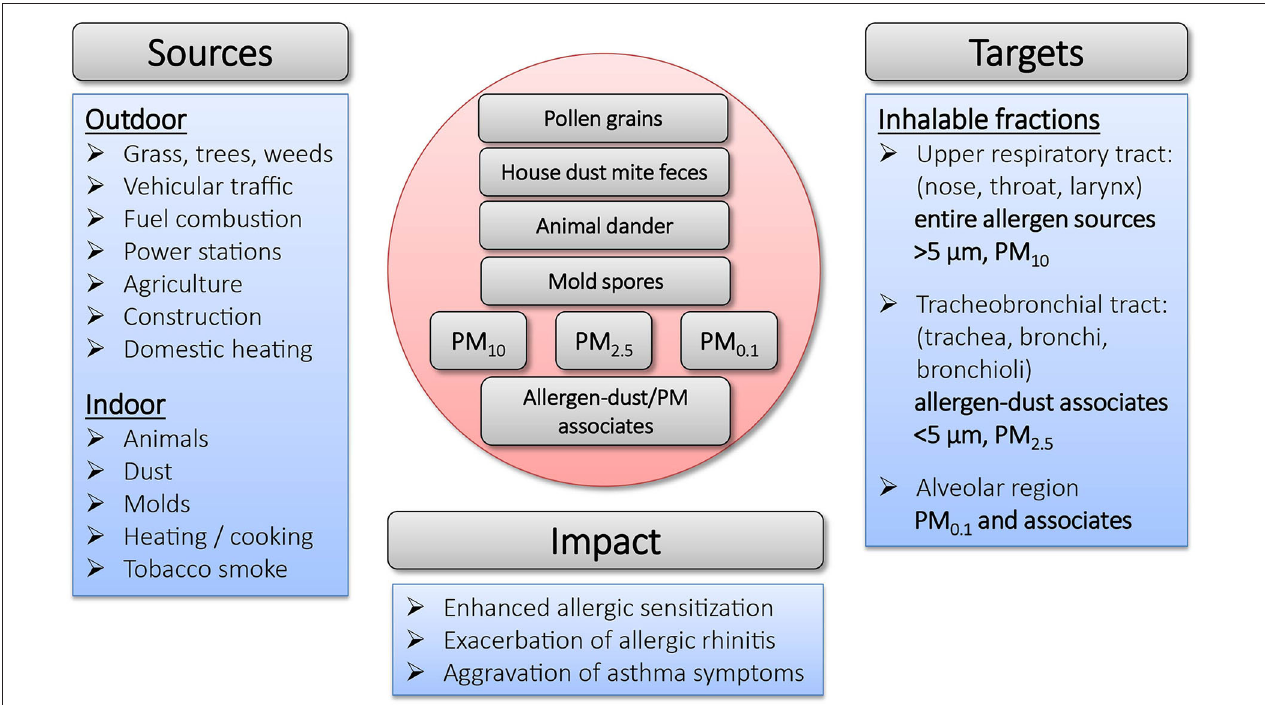
FIGURE 1 | Overview on sources, targets and impact of particulates in allergic